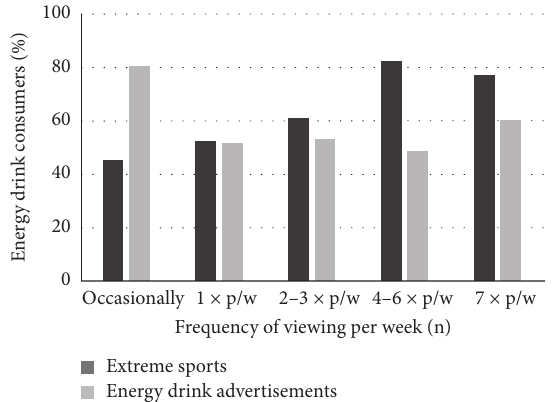
Figure 2: Proportional frequency of viewing of extreme sports and energy drink advertisements by energy drink consumers.